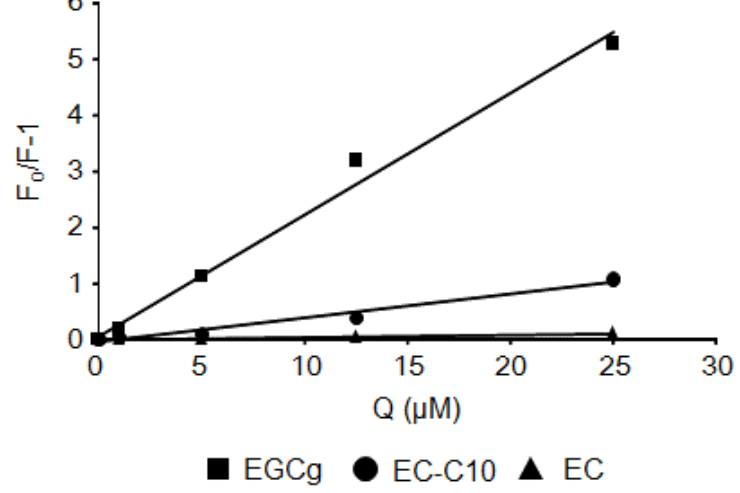
Figure 4. Stern–Volmer plots of catechins and BSA. Representative results for EGCg, EC-C10, and ( − )-EC are shown.